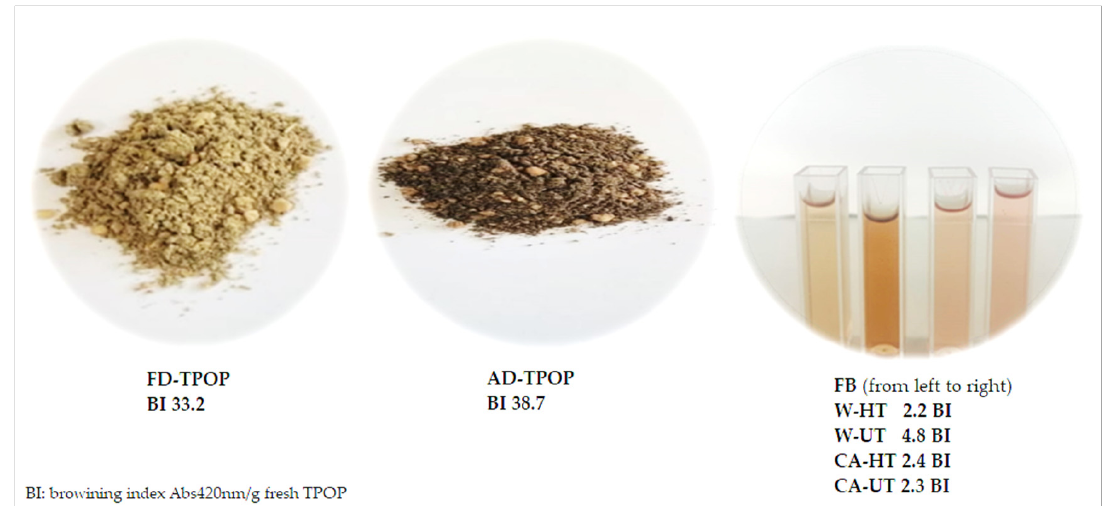
Figure 1. Visual analysis and browning index of freeze-dried (FD-TPOP), air-dried (AD-TPOP), water (W-HT, W-UT) and 6% citric acid (CA-HT, CA-UT) functional beverages. Furthermore, the browning index (BI) is given in Figure Air-drying treatment caused an evident change of the TPOP color to dark brown, due to enzymatic browning [33]. As for drying purposes, a very thin layer of pomace was al- lowed to dry for a very long time (7 days); a large surface area along with time plays key factors in the interaction of atmospheric oxygen with the endogenous polyphenoloxidase (PPO), resulting in a significantly darkening AD-TPOP. Conversely, PPO resulted in being inhibited under freeze drying, as evidenced by the yellow–green color and lower BI of FD-TPOP (Figure 1).